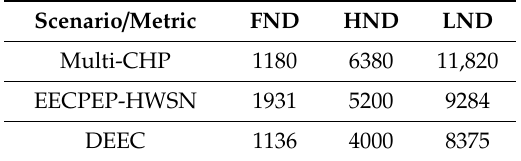
Table 4. The FND, HND, and LND metrics for the di ff erent scenarios of Figure